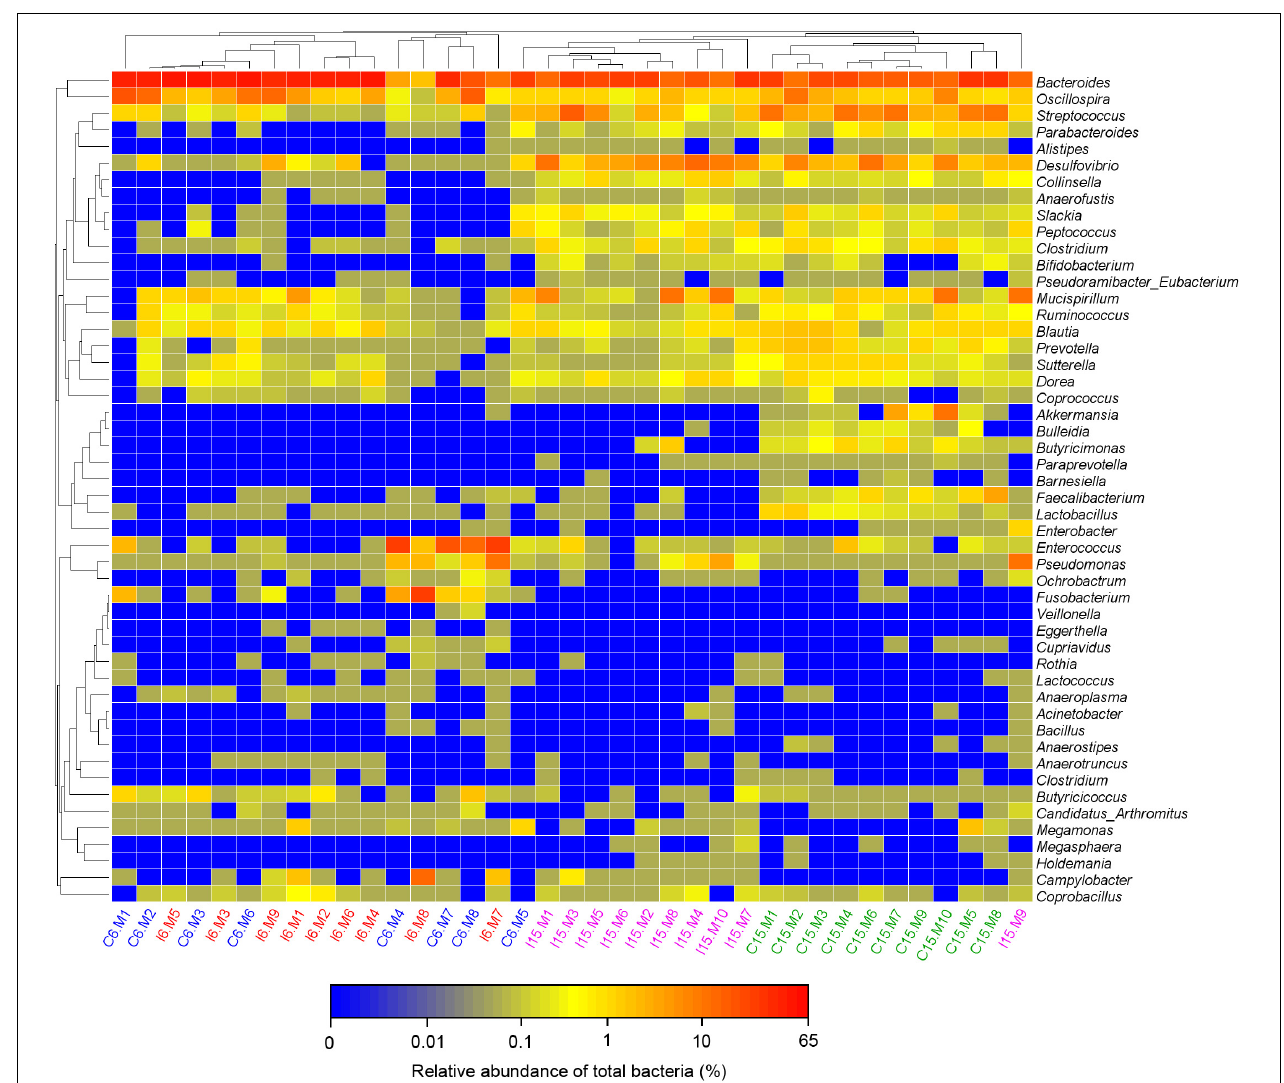
FIGURE 3 | Bacterial distribution of the top 50 abundant genus among 37 samples. Double hierarchical dendrogram shows the bacterial distribution. The heatmap plot depicts the relative percentage of each bacterial genus within each sample. The relative values for bacterial family are indicated by color intensity with the legend indicated under the